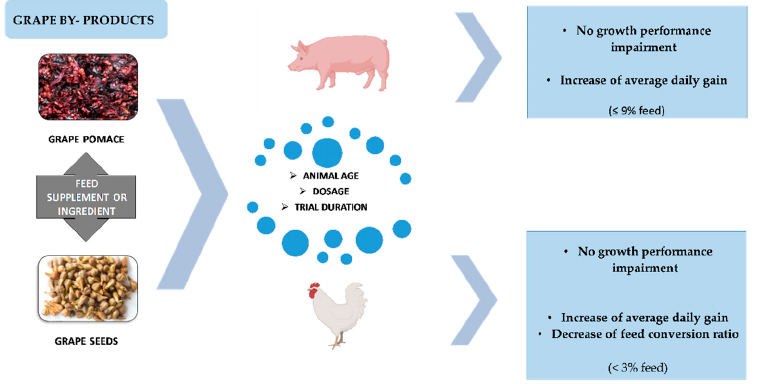
Figure 1. Grape by-products as feedstuff for pigs and poultry and consequences on animal produc- tion performance.